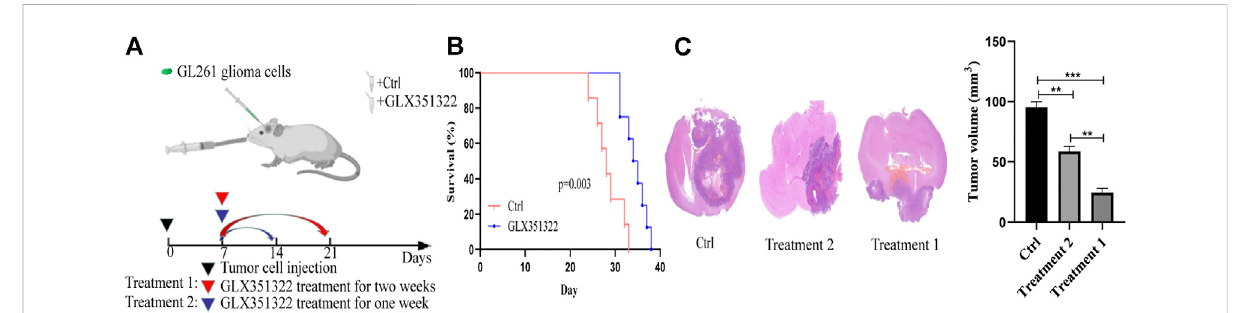
FIGURE 2 Knockdown of NOX4 signi fi cantly inhibits tumor growth in vivo . (A) Schematic diagram of targeted therapy in vivo . Xenograft models were established by intracranial injection of (1 × 10 6 cells), which were directly inoculated into the lateral ventricle of nude mice. The GLX351322 or drinking water was treated every day after 1 week following the xenotransplantation, and treatment was repeated one or 2 weeks; (B) Kaplan – Meier survival curves of tumor-bearing mice received the indicated treatments (n = 7); (C) H&E staining of the brains isolated from mice received the indicated treatments. Scare bar: 100